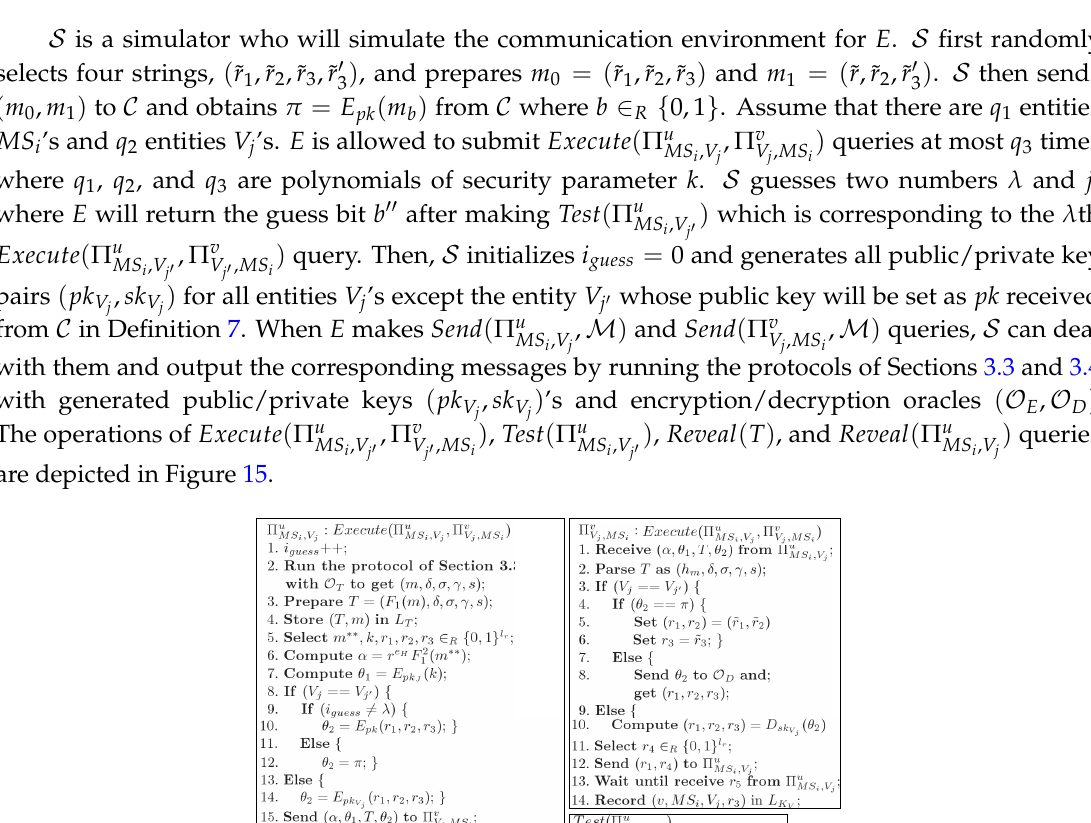
Figure 14. The proof model of Theorem 6.